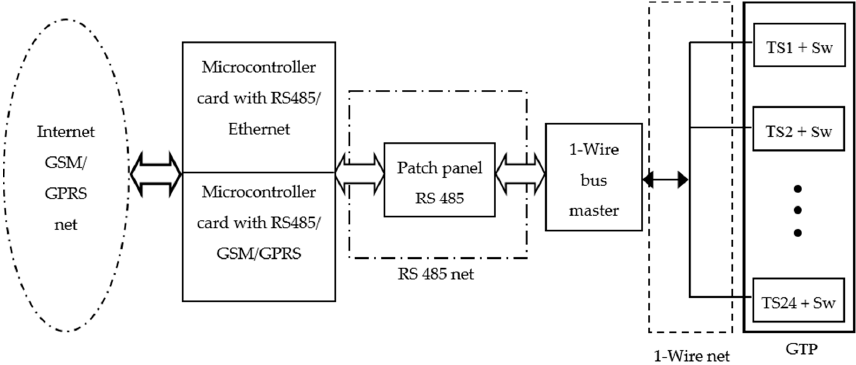
Figure 4. Block diagram of the developed instrumentation system for measuring ground temperature.